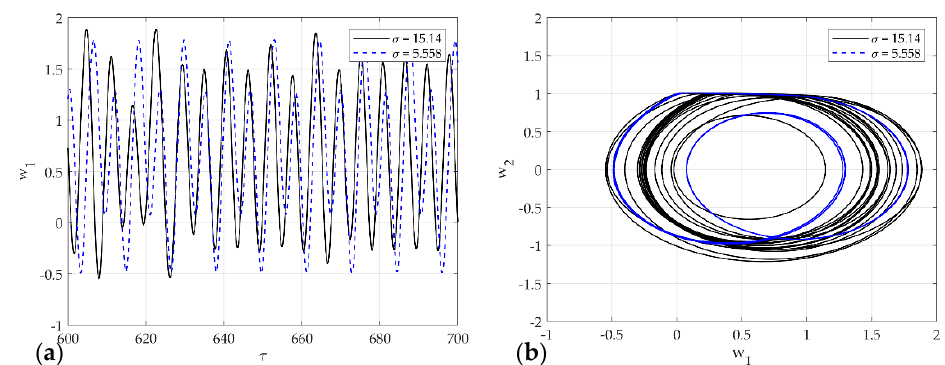
Figure 14. Dynamic solutions for single-mode squeak model for various σ : ( a ) time analysis; ( b ) phase portrait corresponding to ( a ).